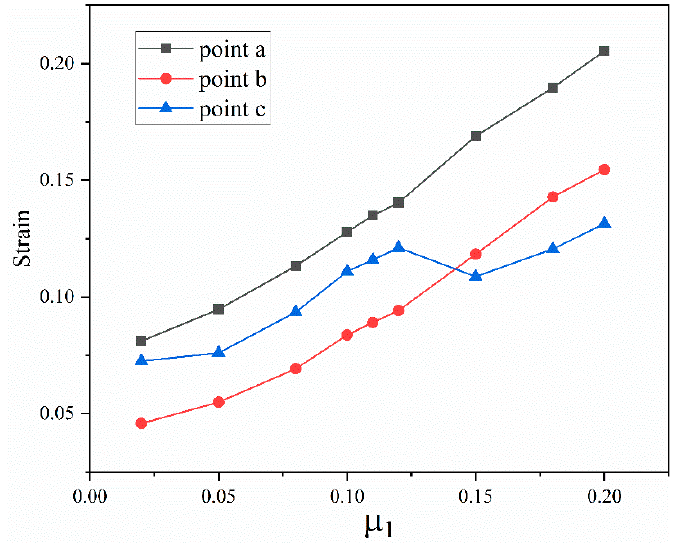
Figure 15. Variation of strain after forming with different friction coefficients at points a, b and c.